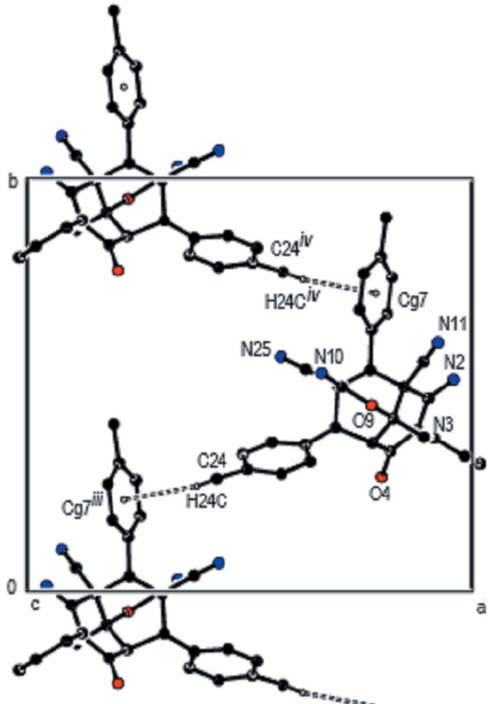
Acta Cryst. (2023). E 79 , 254–258